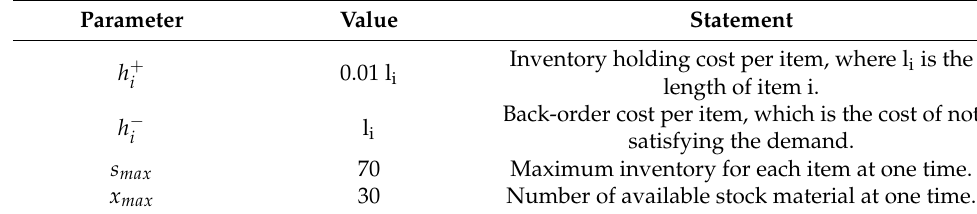
Table 4. Parameters of the environment